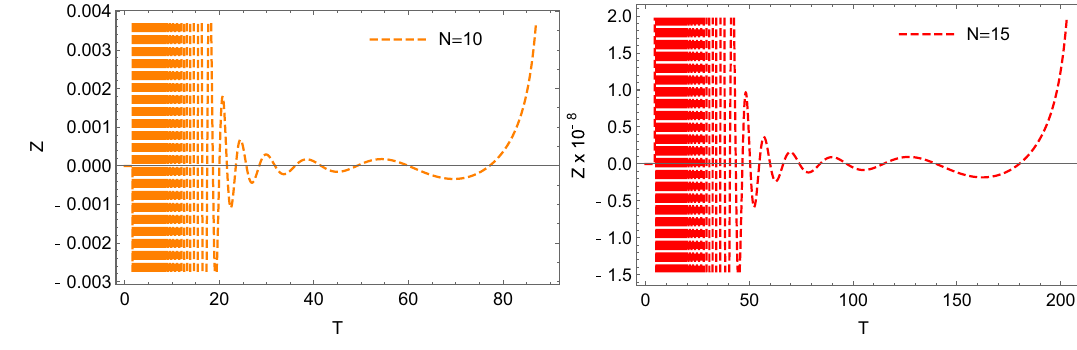
Fig. 1 Partition function in terms of temperature with G = m = k = 1, and λ = 1 / 6